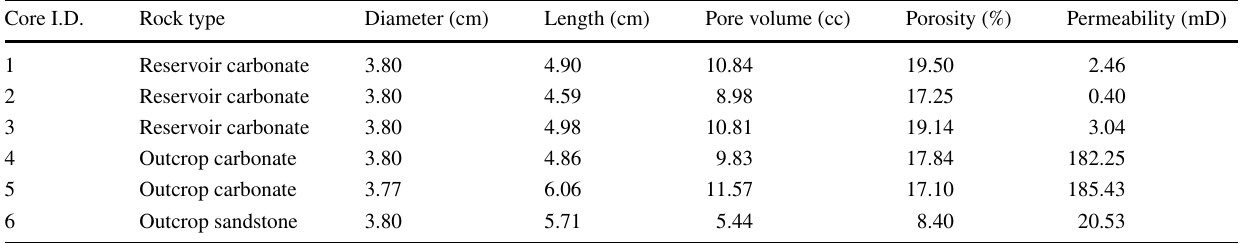
Table 1 Physical properties of the rock samples Core I.D.